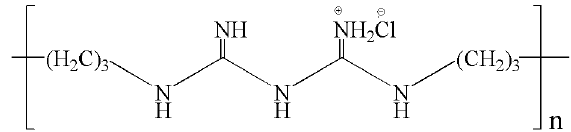
Figure 1. Chemical structure of poly(hexamethylenebiguanide) (PHMB).